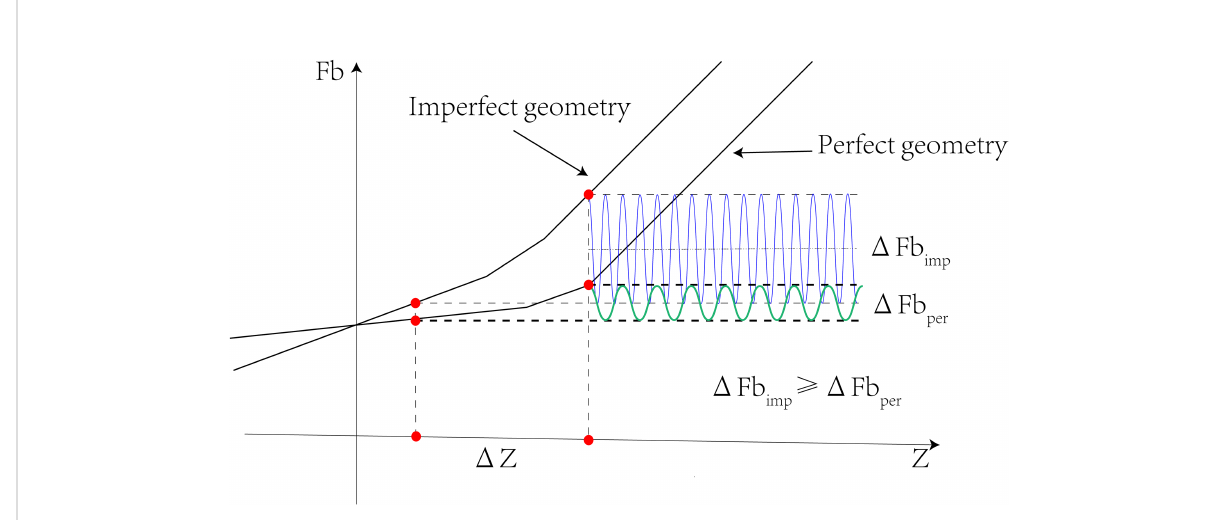
FIGURE 9 The relationship between external force Z and bolt load Fb under perfect and imperfect